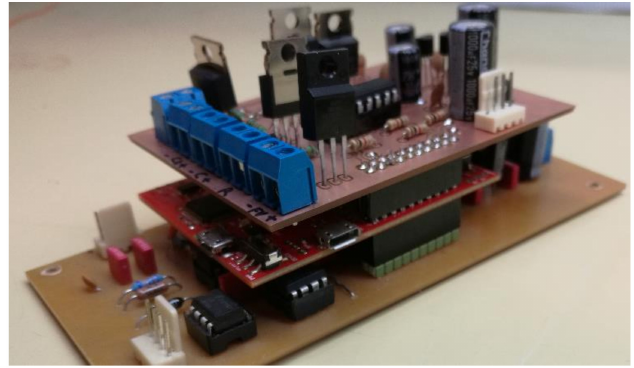
Figure 3. Last version of the prototype boards. The signal conditioning stage is at the bottom, the commercial embedded system board is in the middle and the power stage is at the top.